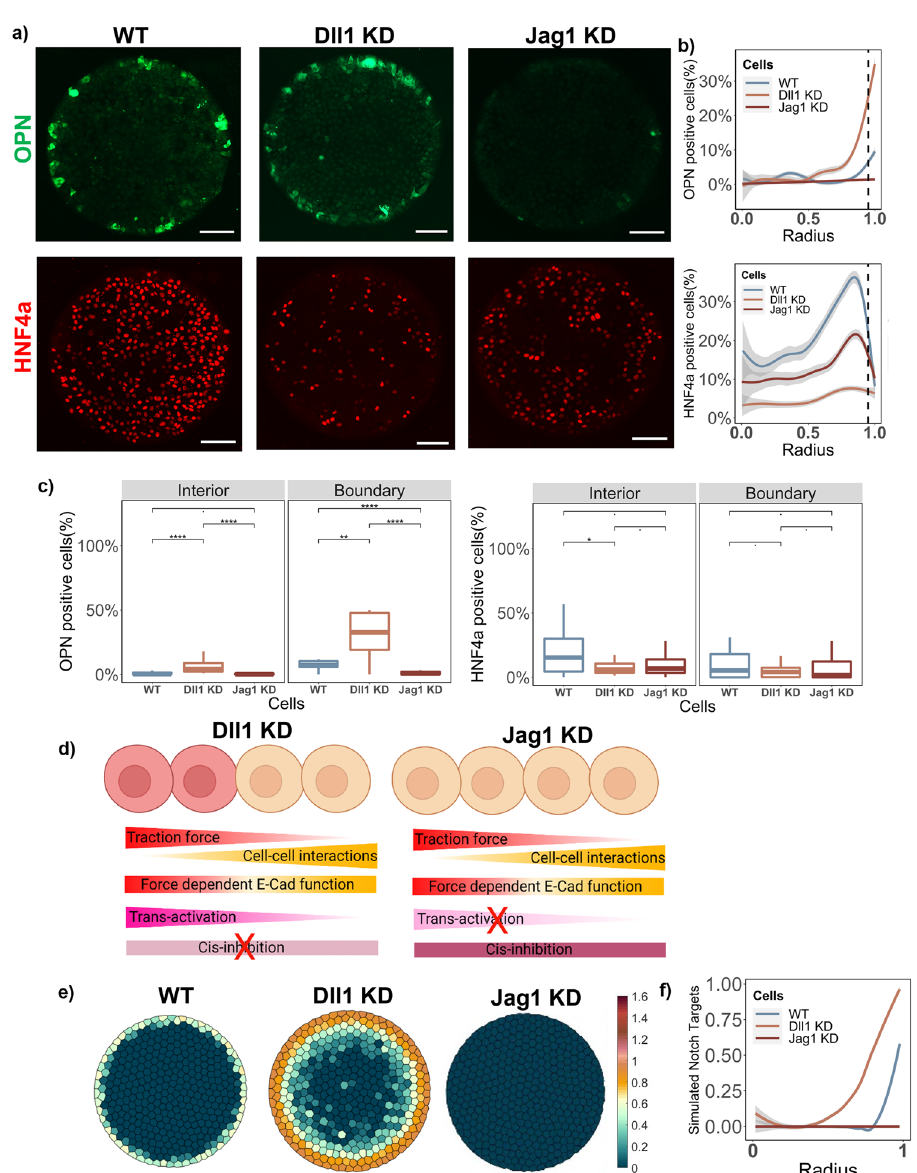
Fig. 3 Effect of intrinsic Notch ligand knockdowns on patterned differentiation. a Representative fl uorescent Images of WT, Dll1 KD, and Jag1 KD BMELs on Col 1 microarrays on 25 kPa polyacrylamide hydrogels. Red: HNF4a, Green: OPN. Scale Bar: 100 μ m. b Quanti fi cation of average percent HNF4a + and OPN + cells/island is as a function of the radius. 0 is center, 1 is the edge, vertical dashed line at radius = 0.95. c Quanti fi cation of average percent HNF4a + and OPN + cells/island in the interior (radius = 0 – 0.95) and at the boundary (radius = 0.95 – 1.00). ‘ . ’ : ns; * p -value < 0.05; *** p -value < 0.001 **** p - value < 0.0001, calculated using Wilcox test in R. d Schematic of the simulated in silico knockdowns for Dll1 KD and Jag1 KD. Made using biorender.com. e Simulated Notch target genes on cells on a circular lattice, with in silico knockdown simulation. Heatmap color: arbitrary unit for Notch target genes. f Quanti fi cation of simulated Notch target genes in cells on a circular lattice for the in silico knockdowns. Line plots — Gray: 95% con fi dence interval. n ≥ 4 biological replicates (independent experiments) and n ≥ 15 technical replicates (individual